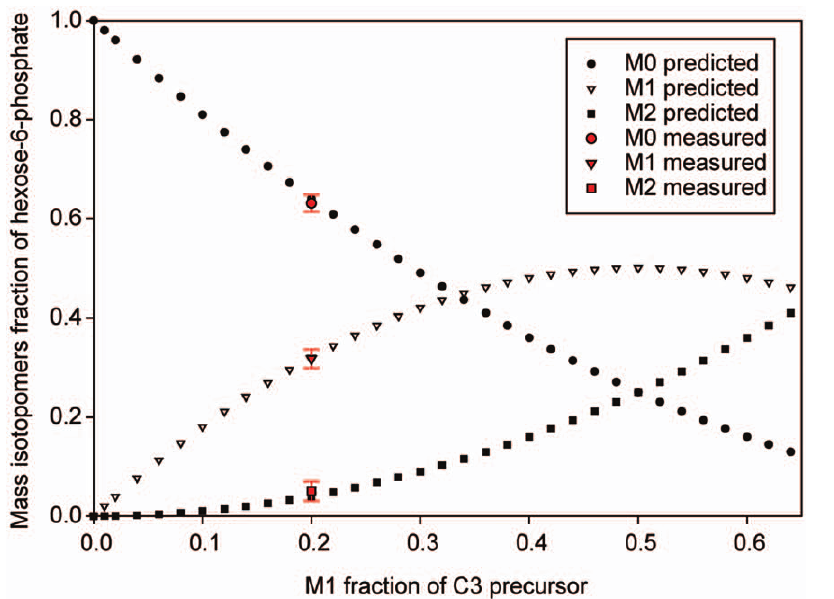
Figure 4. Prediction of the mass isotopomer distribution of hexose-phosphate depending of the M1 mass isotopomers fraction into C3 precursors of gluconeogenesis. Black, predicted values; red, measured values. The mass isotopomer fraction of hexose-phosphate measurements were 0.63 6 0.017 for M0, 0.32 6 0.019 M1, 0.05 6 0.020 M2, and 0.002 6 0.020 M3. These values correspond to the probabilistic recombination of two C3-units from gluconeogenesis assuming that 20% of the C3 units have incorporated one 13 C carbon and 80% of the units are not labeled.